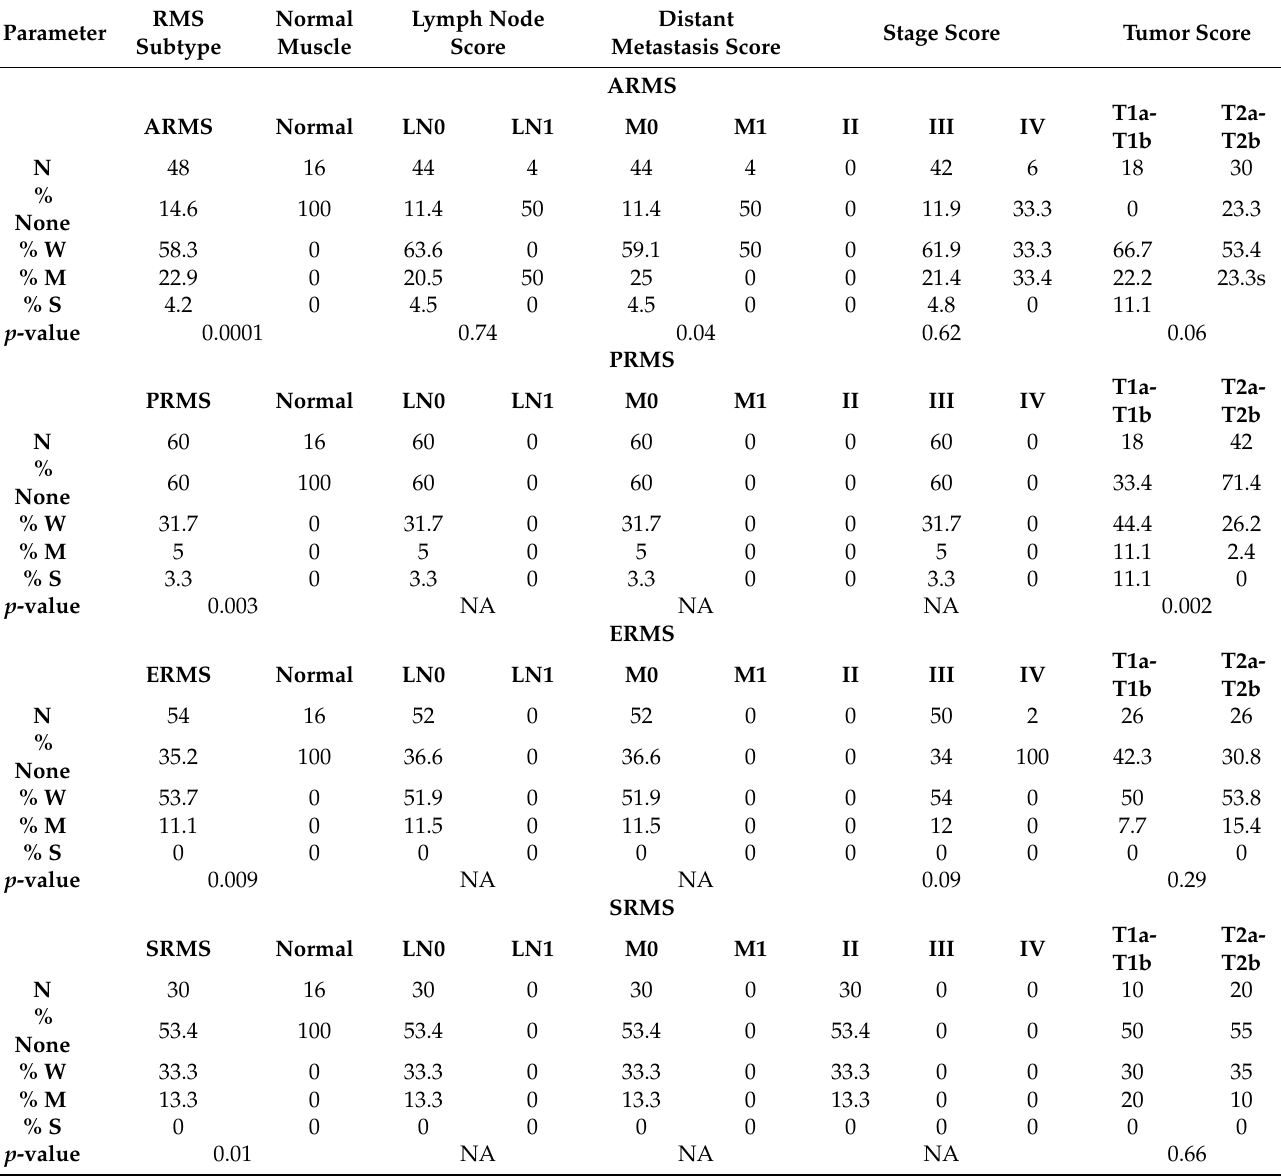
Table 5. Correlation of sXBP1 protein expression with the clinicopathological features of RMS subtypes.